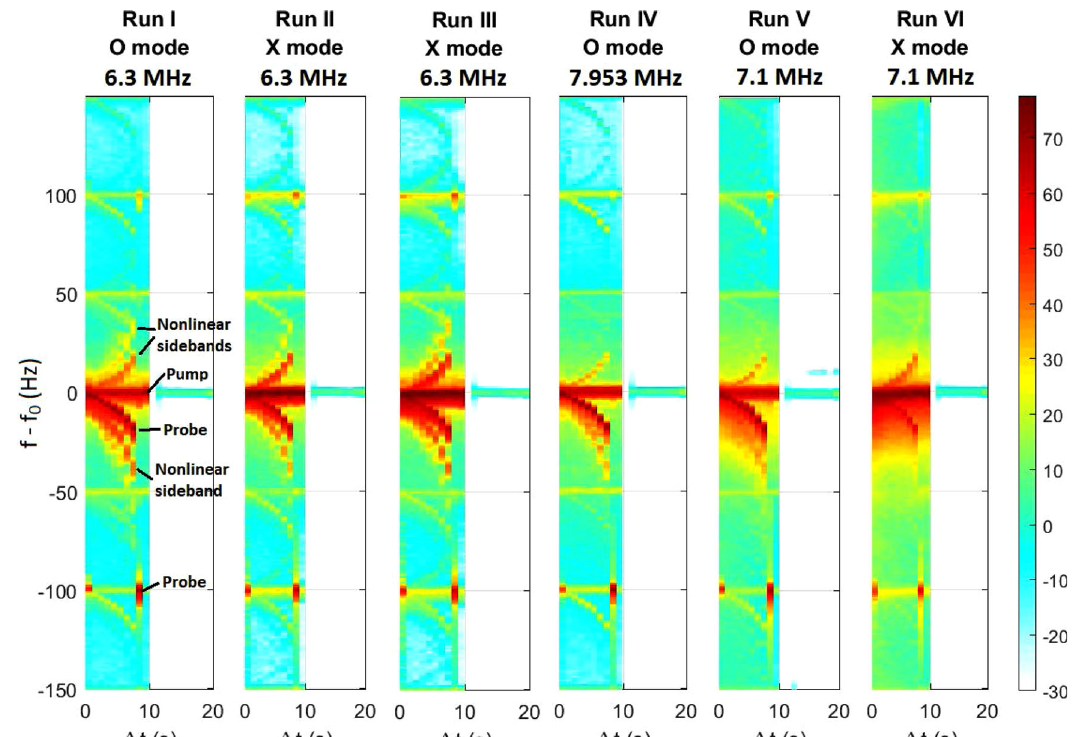
Fig. 2 Spectrograms (dB) of recorded return signals in the experiment. The spectrograms are averaged over the experimental cycles (Table 1